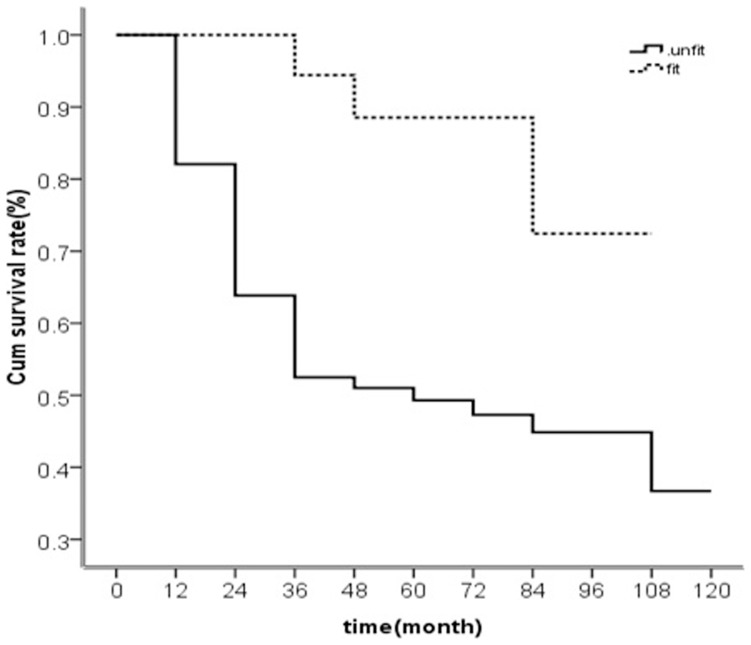
Kaplan-Meier analysis of the overall survival rates of patients who were fit and unfit for the revised criteria in the exceeding UCSF group.